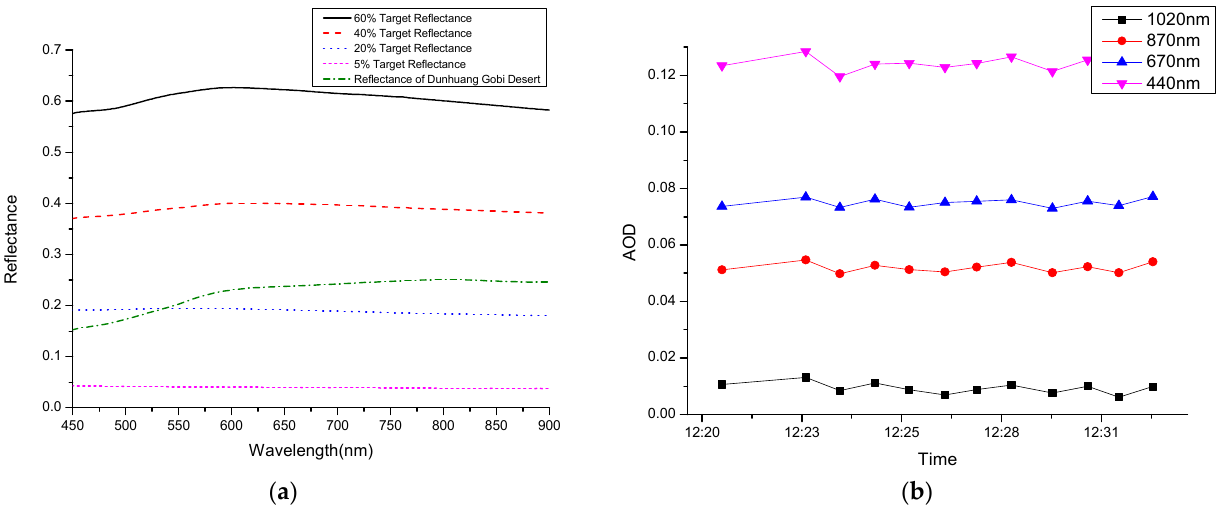
Figure 6. ( a ) Measured ground reflectance of the multi-grayscale targets on 18 August 2018 (overpass time: 12:28). ( b ) Aerosol optical depth on 18 August 2018.